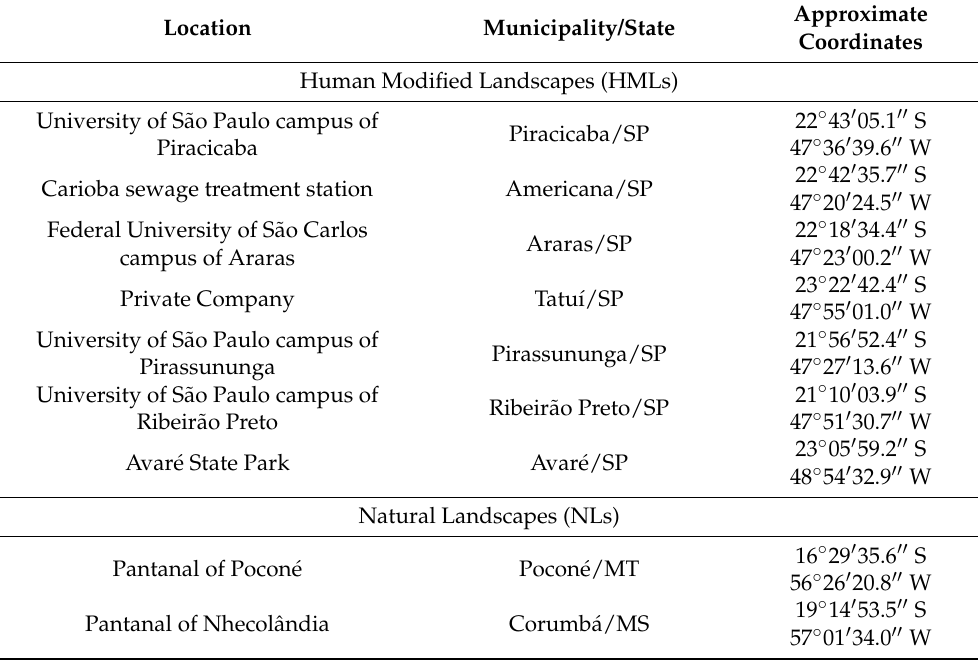
Table 1. Location of capybara captures and